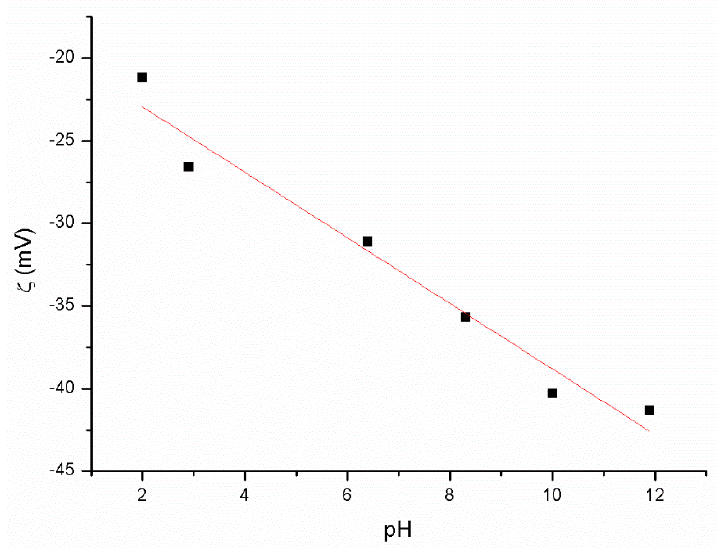
Figure 5. Zeta potential ( ζ ) of GO/H 2 O dispersion in pH dependency.